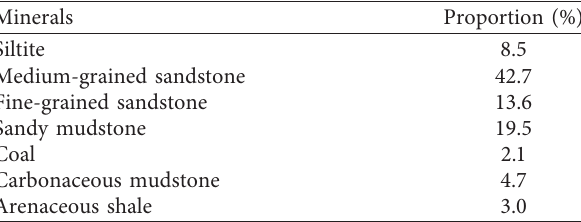
Table 2: Mineralogical composition of coal gangue.